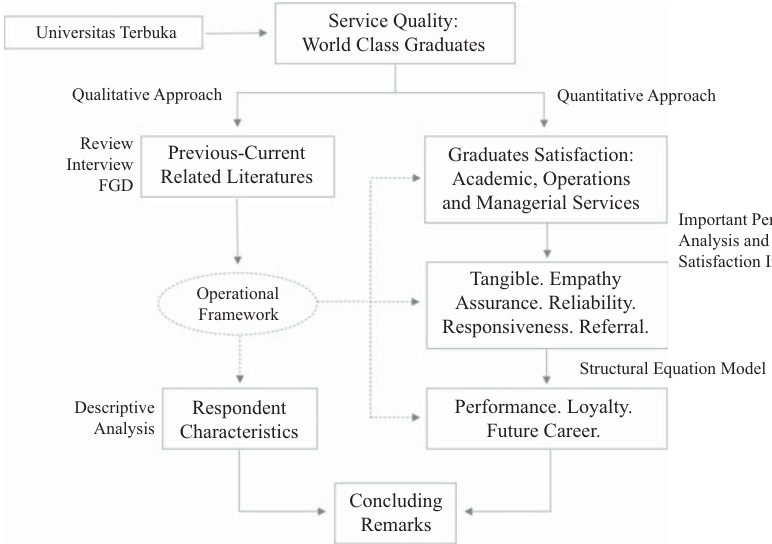
Figure 1. Conceptual